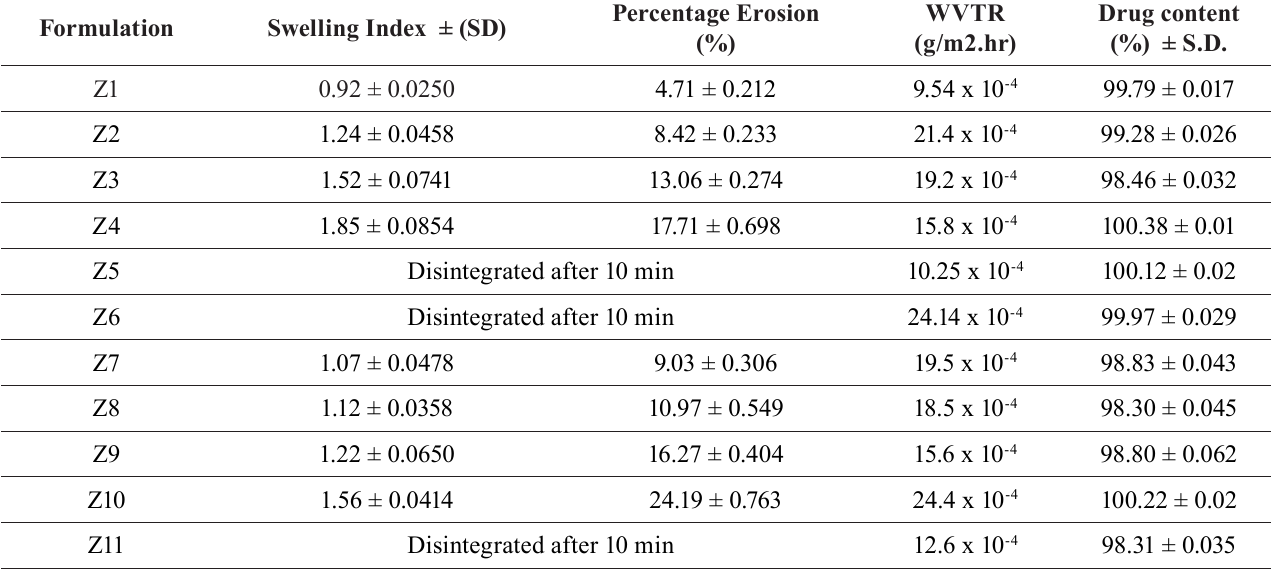
Table III. Results of swelling index, percentage erosion, water vapor transmission rate and drug content matrix transdermal patch of